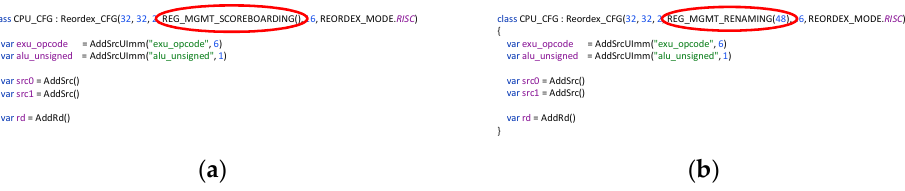
Figure 8. Configuration object example for Reordex KIP core: scoreboarding ( a ) and register renaming ( b ). Table 3. “Microarchitectural middleware” design level features of Reordex KIP core.